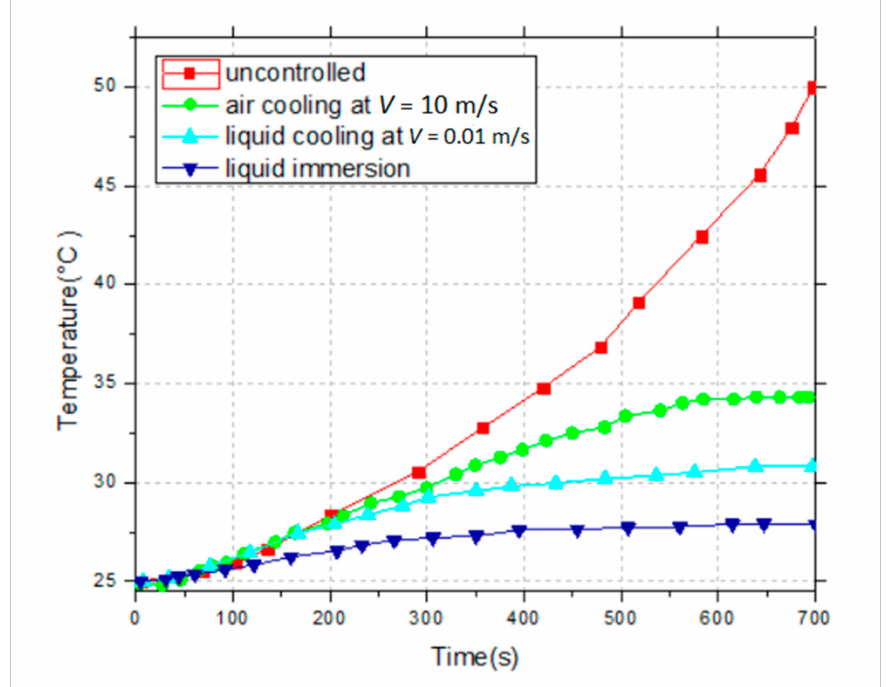
Figure 10. Temperature rise comparison between the uncontrolled and the liquid immersion cooling